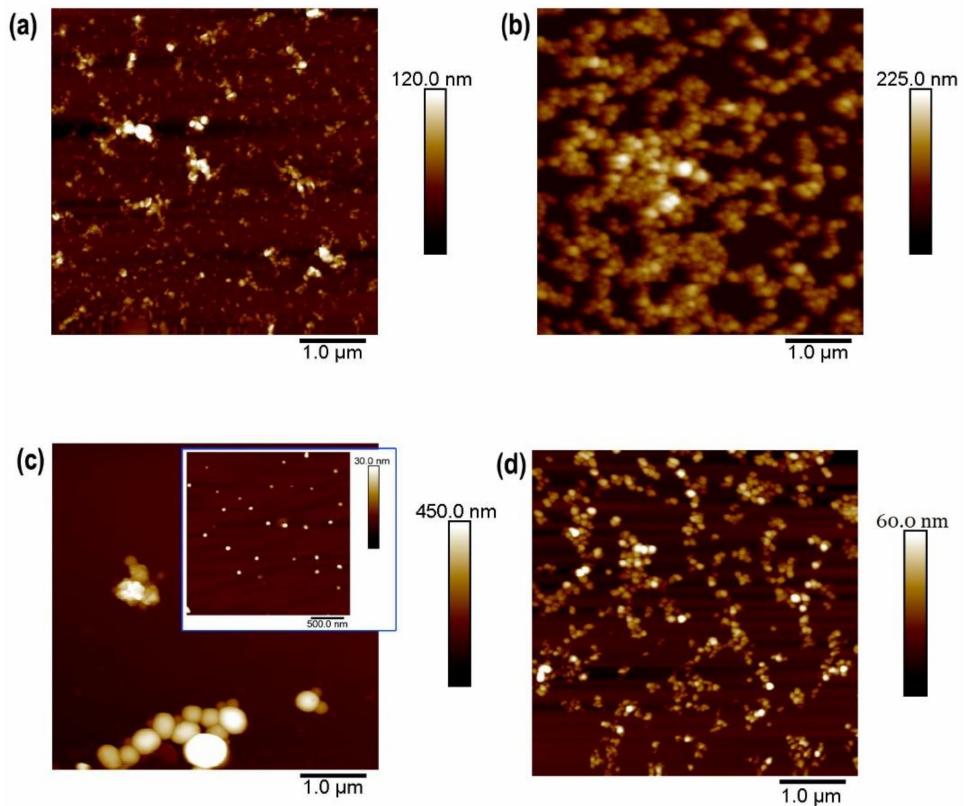
Figure 2. Examples of nanoparticles composing water-based inks, prepared by different tech- niques. AFM topography for ( a ) P3HT nanoparticles prepared by miniemulsion; ( b ) poly(vinylidene fluoride-co-trifluoroethylene) (P(VDF-TrFE)) nanoparticles prepared by flash nanoprecipitation; ( c ) poly(vinylidene fluoride) (PVDF) nanoparticles prepared by dialysis nanoprecipitation. The inset shows the amplificated z scale of the same image to highlight the presence of a bimodal size distribution of nanoparticles; ( d ) [6,6]-phenyl C 71 butyric acid methyl ester (PC 71 BM) nanoparticles prepared by